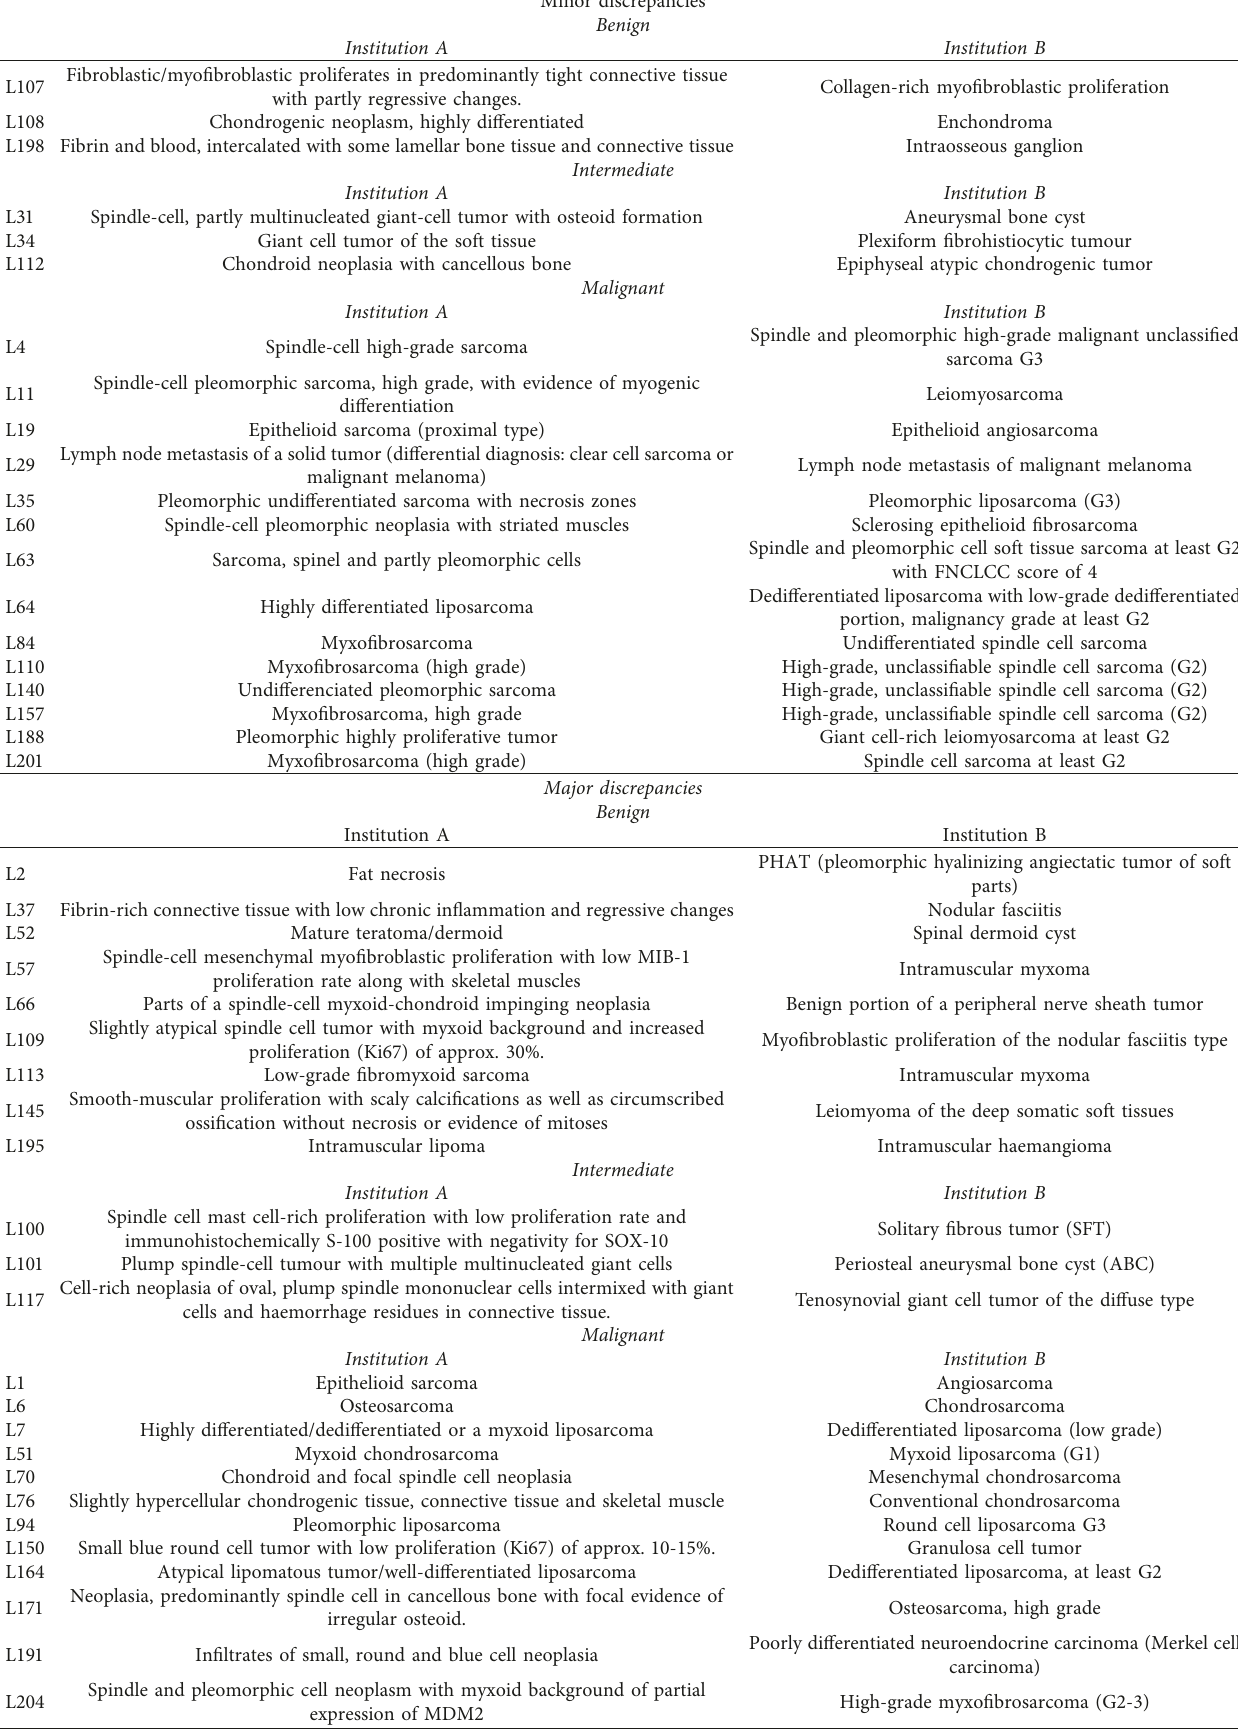
Table 3: Minor/major